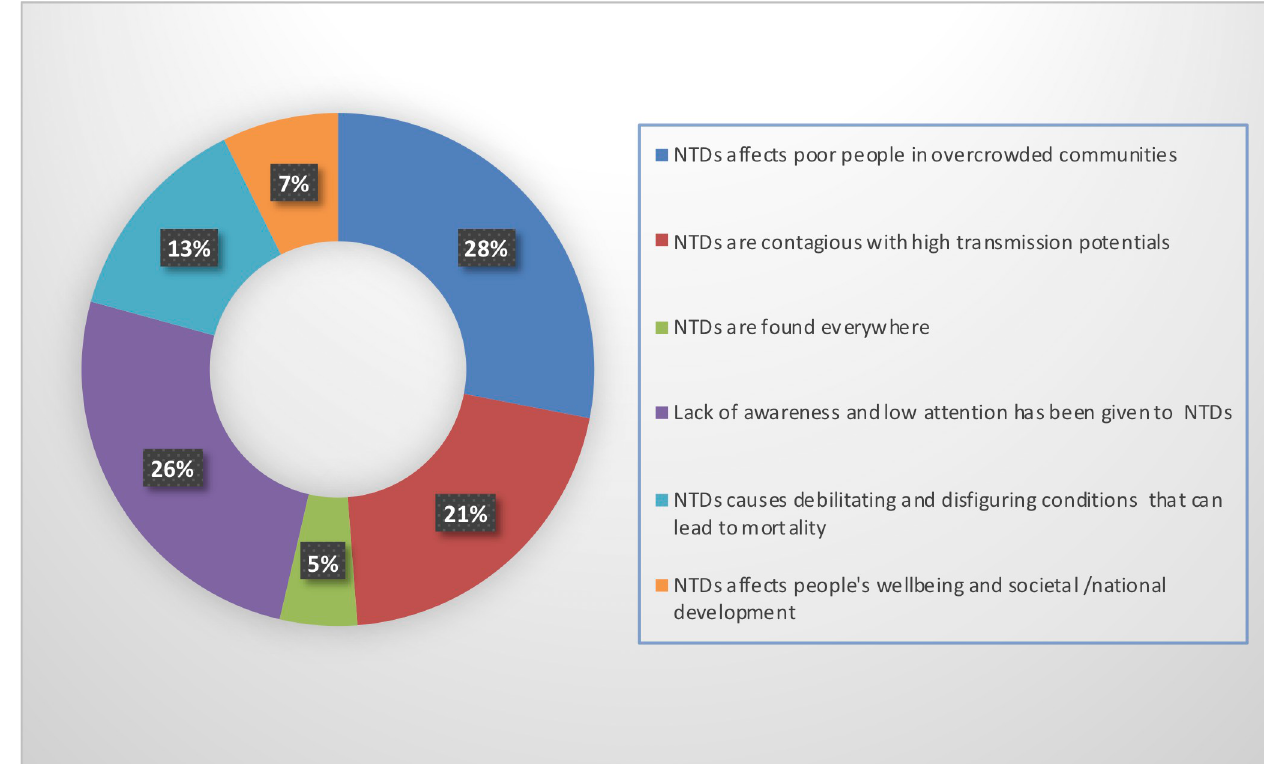
Fig 2. Perceptions of attendees on why NTDs is a public health